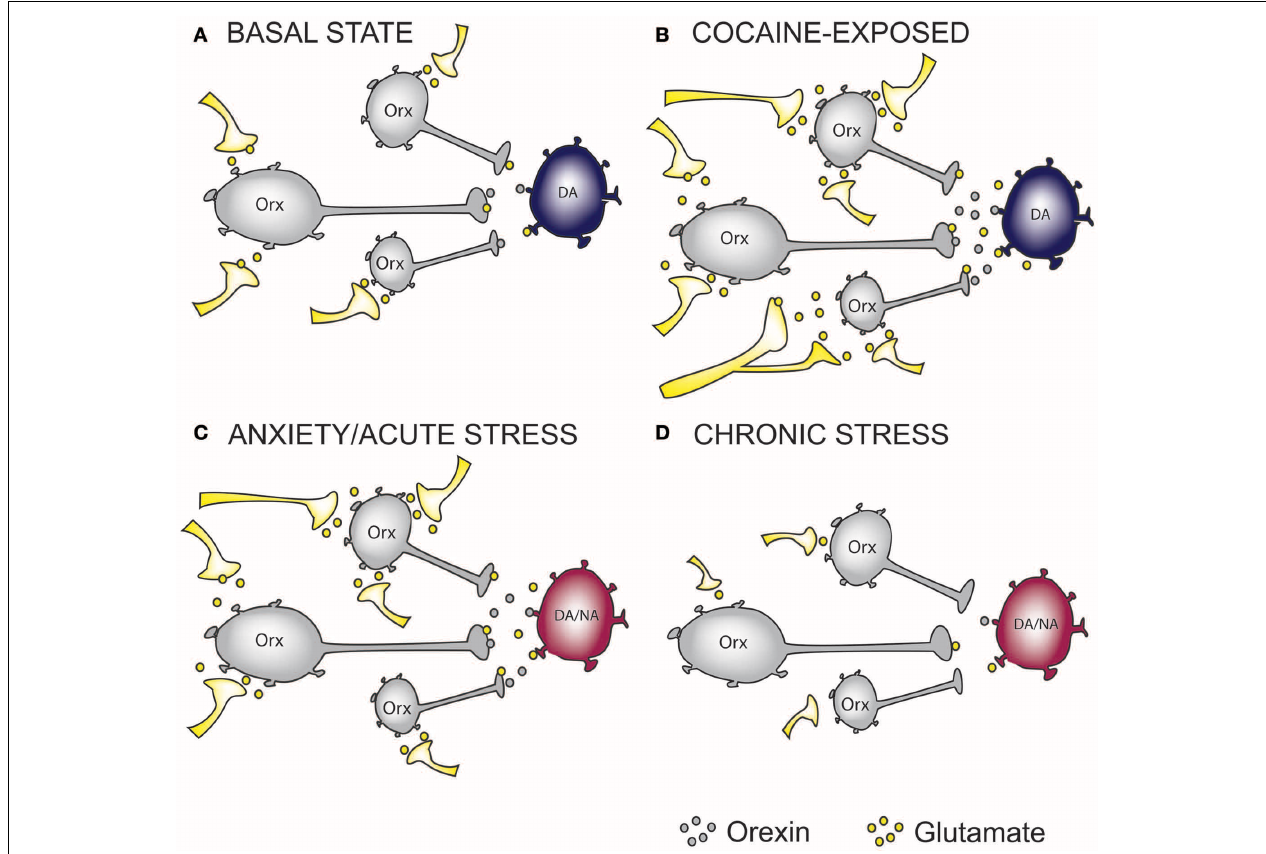
FIGURE 1 | The effect of cocaine and stress exposure on orexin neurons. (A) Under basal conditions, orexin (Orx) neurons in the lateral hypothalamus receive excitatory inputs, thus providing “normal” glutamatergic and orexinergic (excitatory) tone onto downstream projection targets such as ventral tegmental area (VTA) dopamine (DA) neurons. (B) Based on recent studies, we propose that chronic cocaine-exposure rewires glutamatergic inputs onto Orx neurons resulting in increased excitatory drive onto DA neurons in the VTA. (C) Anxiety and acute stress are able to cause enhanced excitatory drive to DA neurons in the VTA and Noradrenergic (NA) neurons in the Locus Coeruleus (LC), an important projection target of